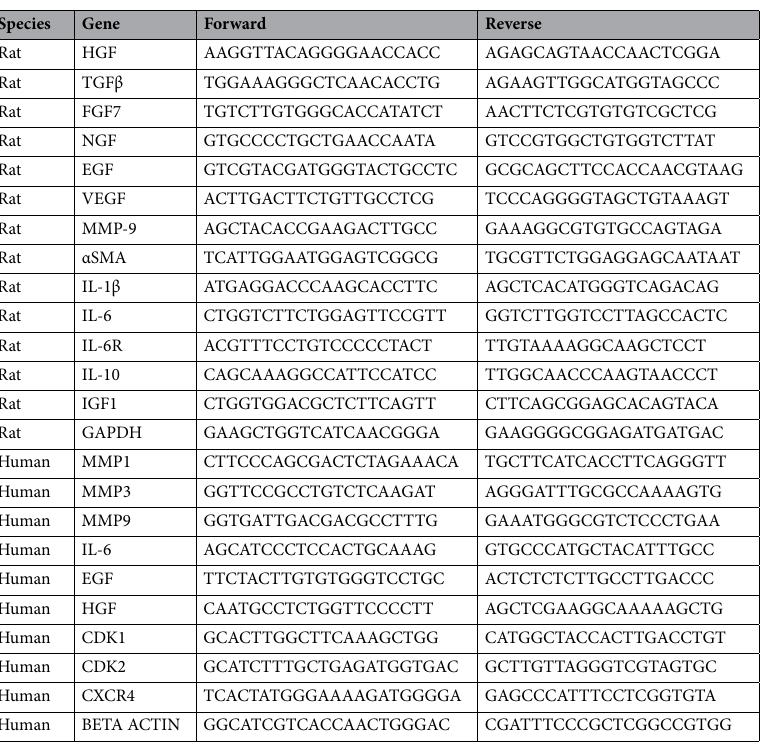
Table 1. Primer sequences used for gene expression analysis by